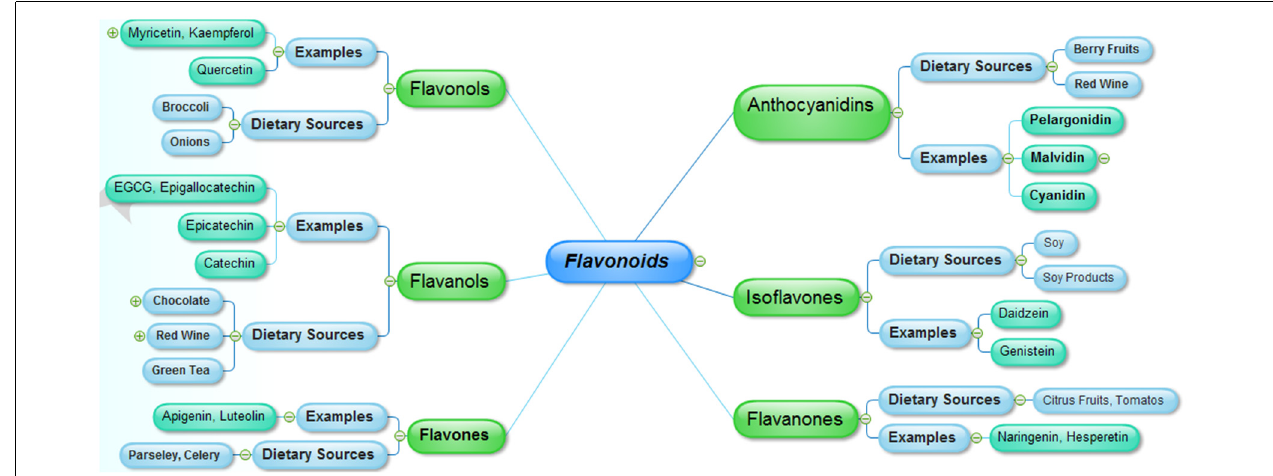
FIGURE 1 | The major classes of flavonoids and their dietary